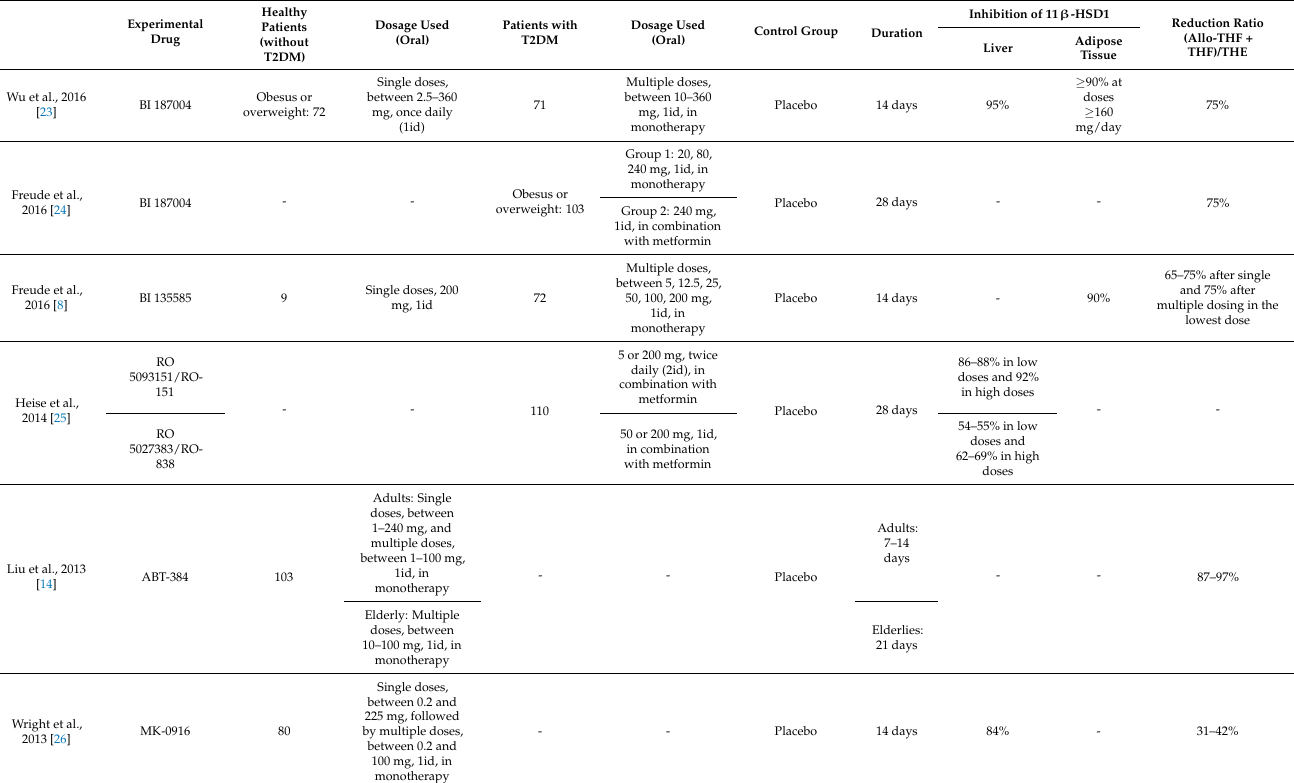
Table 2. Results of clinical trials (phase I-II studies) with selective 11 β -HSD1 inhibitors. Experimental